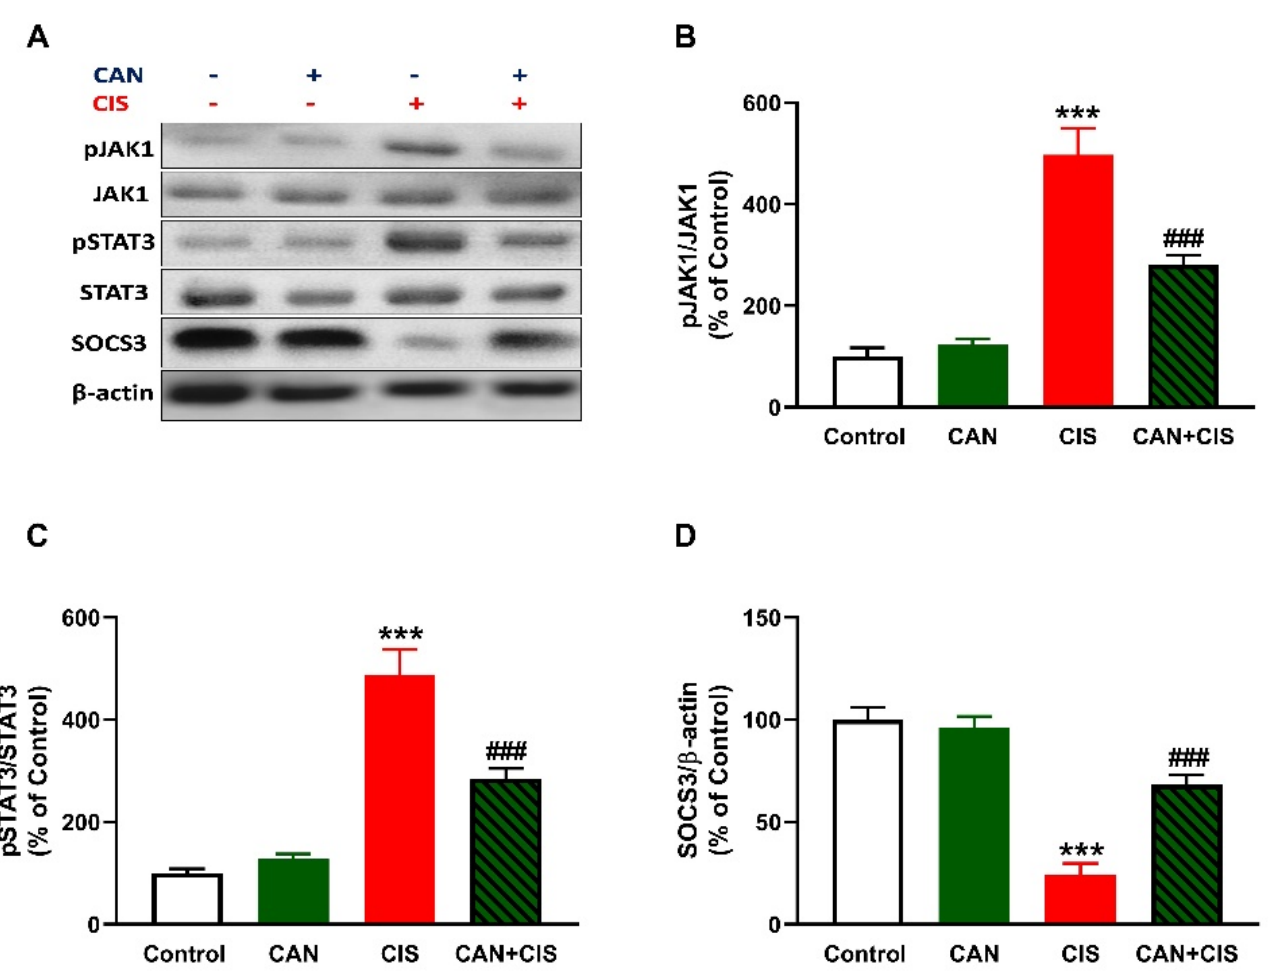
Figure 7. CAN downregulated JAK1/STAT3 signaling in CIS-administered rats. ( A ) Representative blots of phosphorylated and total JAK1 and STAT3, SOCS3, and β -actin. ( B – D ) CAN decreased JAK1 phosphorylation ( B ) and STAT3 phosphorylation ( C ), increased SOCS3 ( D ) in the lungs of CIS-administered rats. Data are Mean ± SEM, ( n = 8). *** p < 0.001 versus Control, and ### p < 0.001 versus CIS.